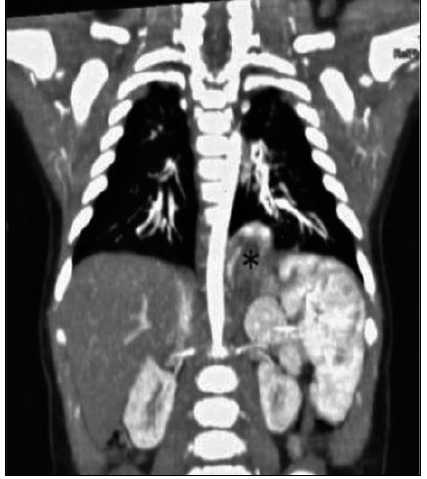
Figure 2: Postnatal computed tomography image showing a triangular-shaped lesion in the lower- left hemithorax, not communicating with the bronchial tree (*). The lesion had an arterial supply from the celiac trunk.